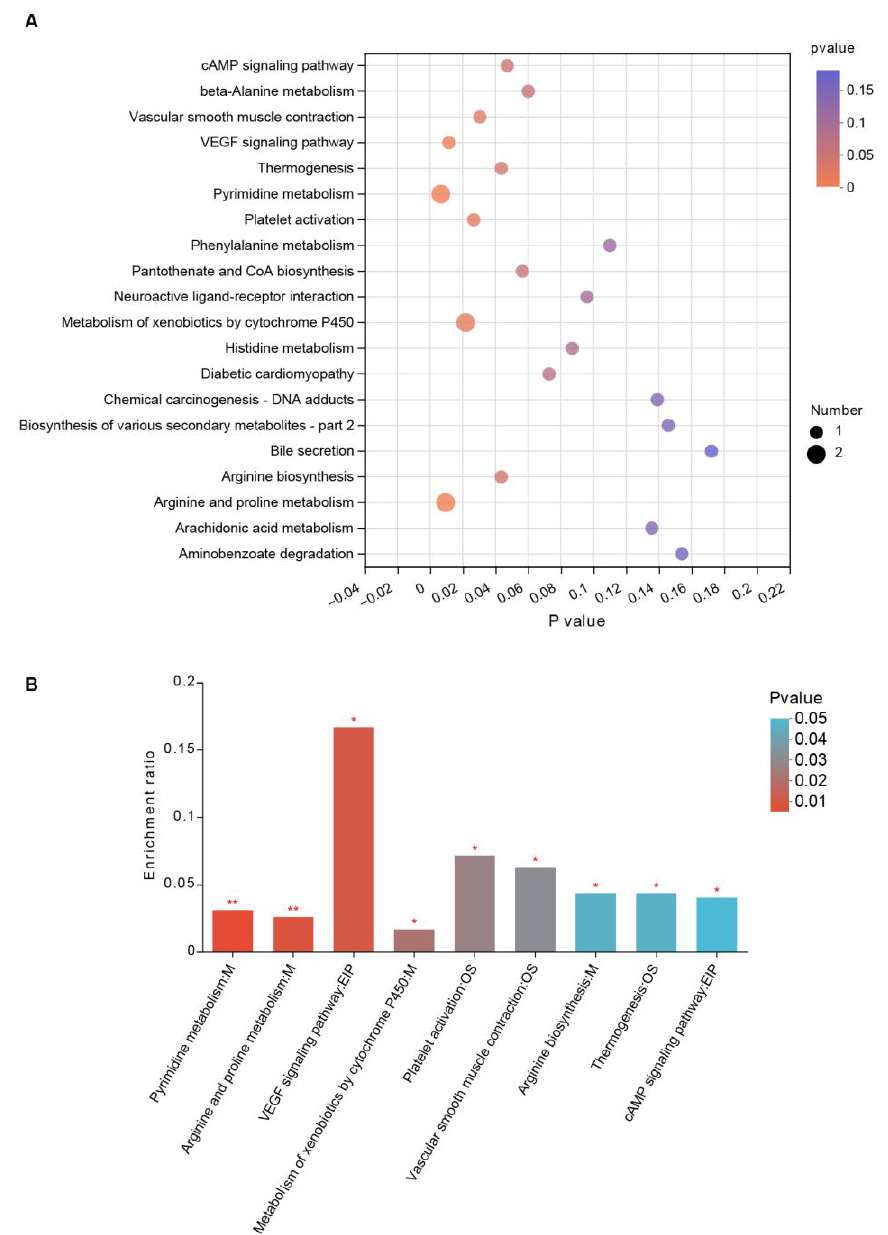
Figure 6. KEGG pathway enrichment analysis reveals the biological significance of gut microbiota metabolites by feeding jujube. ( A ) Bubble chart of KEGG pathway enrichment between the jujube and control groups. ( B ) Significant metabolites of the KEGG pathway enrichment between the jujube and control groups. * p < 0.05, ** p < 0.01.